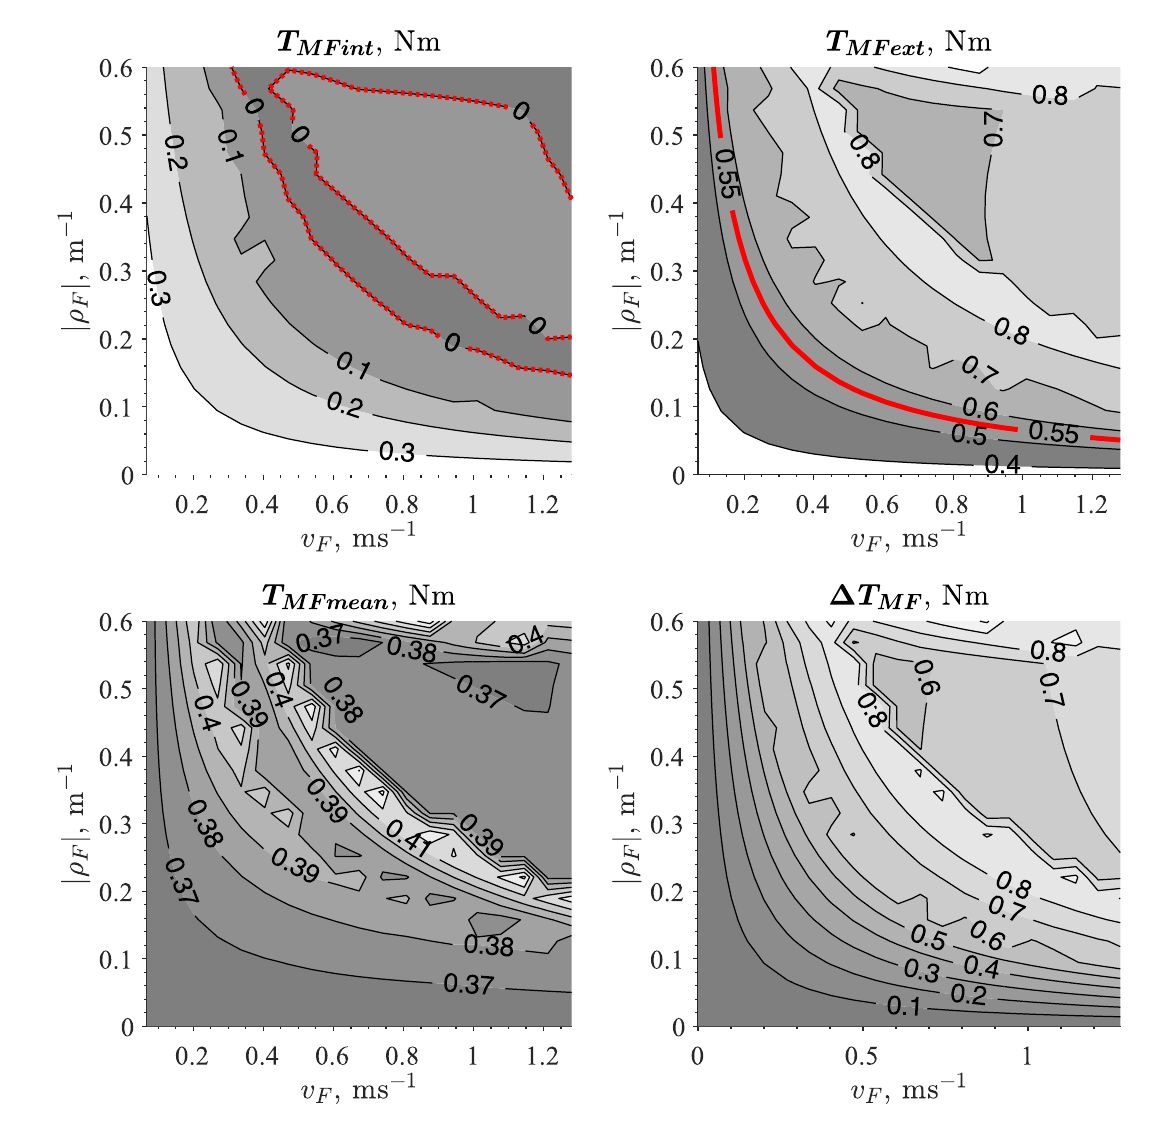
torque and the bottom right shows the difference between the two front torques. The red dotted line highlights the zero torque value, whereas the solid red line highlights the motor nominal torque of